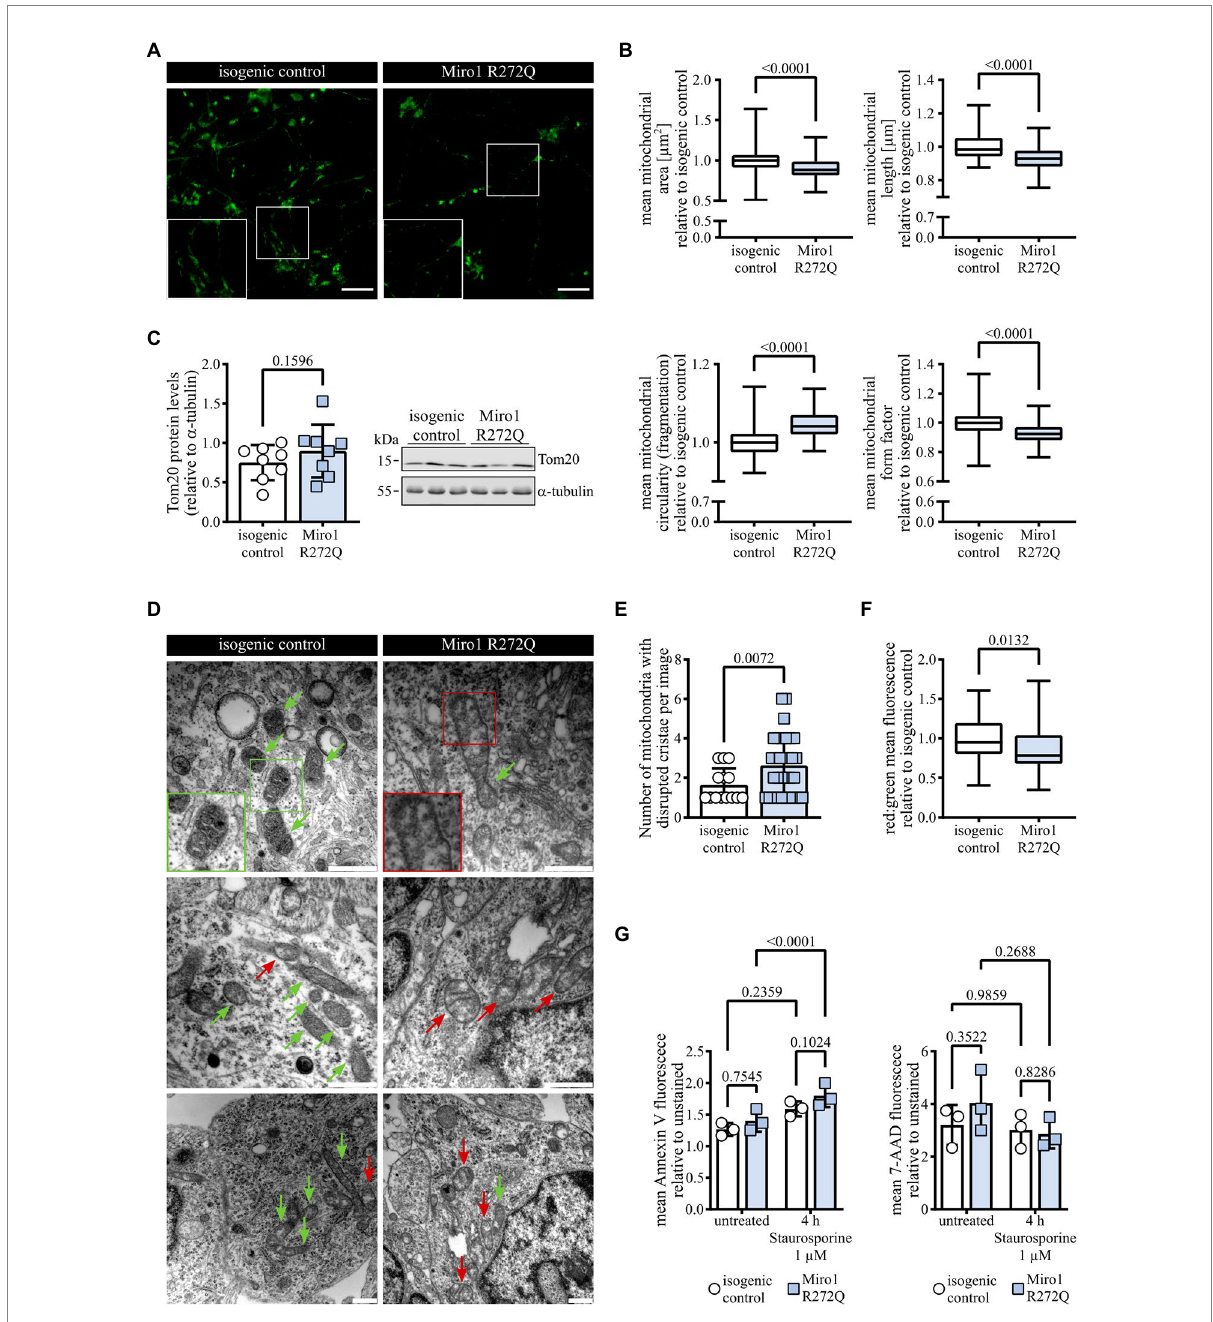
FIGURE 2 Miro1 R272Q alters mitochondrial morphology concomitant with changes in cristae organization. (A) Representative image of hDaNs stained with 100 nM MitoTracker green to label mitochondria for analysis of mitochondrial morphology. Scale bar: 50 μ M. (B) Analysis of mitochondrial morphology of hDaNs stained with 100 nM MitoTracker green to assess mitochondrial area, length, fragmentation, and form factor. Values of one differentiation normalized to mean of isogenic control of the same differentiation. n Diff = 3 (20 images per differentiation), data displayed as mean ± SD; Mann–Whitney test. (C) Tom20 protein levels in hDaN lysates. Representative blot and quantification of intensity of Tom20 bands relative to a-tubulin. n Diff = 8, data displayed as mean ± SD; paired t test (two-tailed). (D) Representative electron microscopy of hDaNs. Red arrows indicate mitochondria with regions devoid of cristae, green arrows indicate mitochondria with maintained cristae. Scale bar: 500 nm. (E) Blinded quantification of mitochondria with disrupted cristae structure per EM image. n Diff = 3, data displayed as mean ± SD; Welch’s t test (two-tailed). (F) Assessment of mitochondrial renewal in hDaNs by transfection with pMitoTimer. Quantification of mean red:green fluorescence and normalization of values of one differentiation to mean of isogenic control of the same differentiation. n Diff = 3 (n images = 42), data displayed as mean ± SD; Mann–Whitney test. (G) Flow cytometric assessment of susceptibility to apoptosis. hDaNs treated for 4 h with 1 μ M Staurosporine were stained with apoptotic marker Annexin V and necrotic marker 7-AAD. Mean fluorescence of each channel normalized to unstained signal. n Diff = 3, data displayed as mean ± SD; Two-way ANOVA with Tukey’s multiple